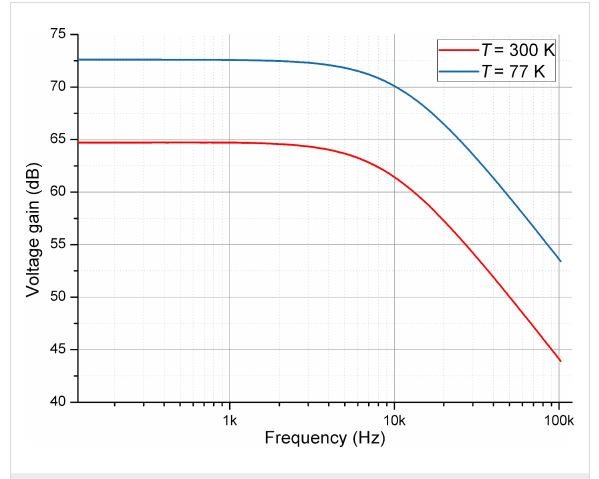
Figure 2: The gain of the cryogenic differential BJT amplifier depending on the frequency at 77 and 300 K.